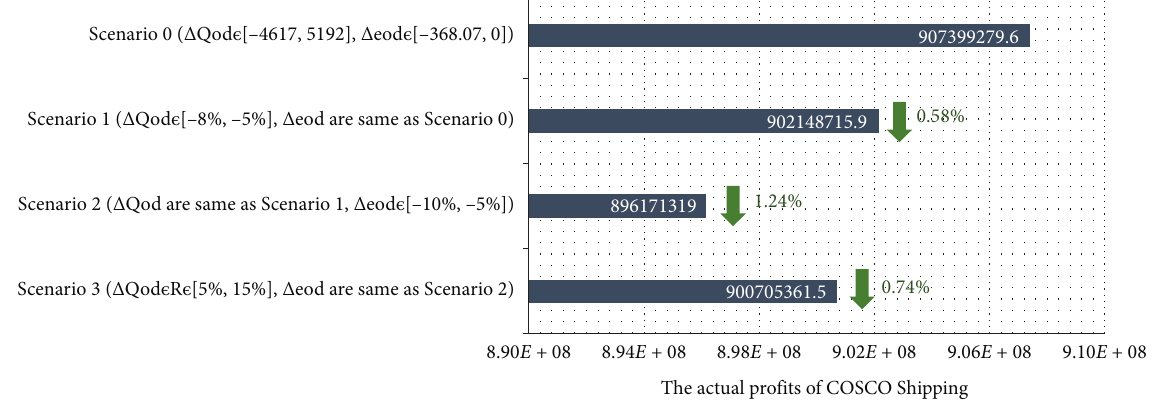
Figure 7: The actual profits of COSCO Shipping in Scenarios 1–3.